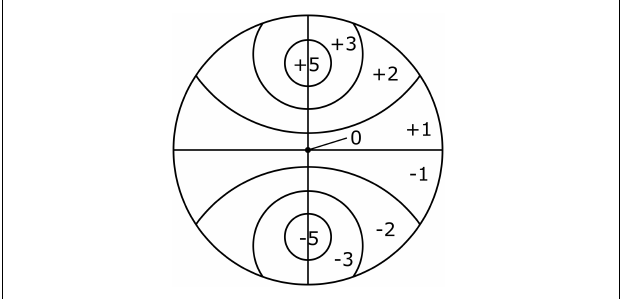
FIGURE 2 | Scoring plate used to investigate the effects of resource diversity on taxis-to-food of the four cryptic species of L. marina (Monteiro et al.,